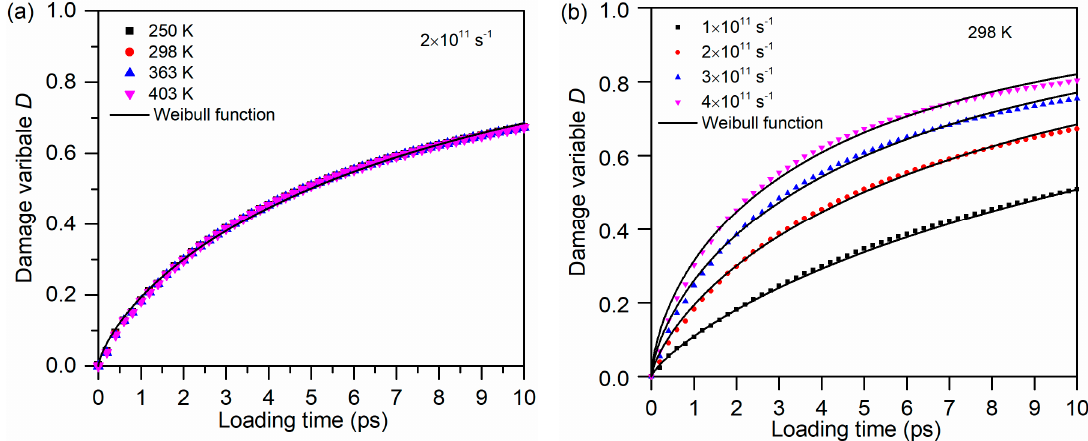
Figure 13. The damage variable of the glass fiber/PP material system during tensile loading under different loading conditions: ( a ) loading temperatures and ( b ) strain rates.